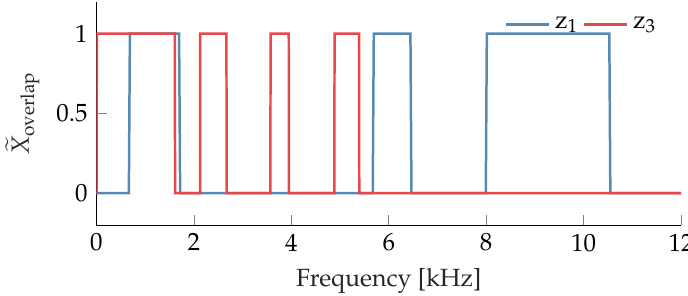
Figure 15. Overlapping frequency ranges of spectra (cid:101) X ∆ ,S